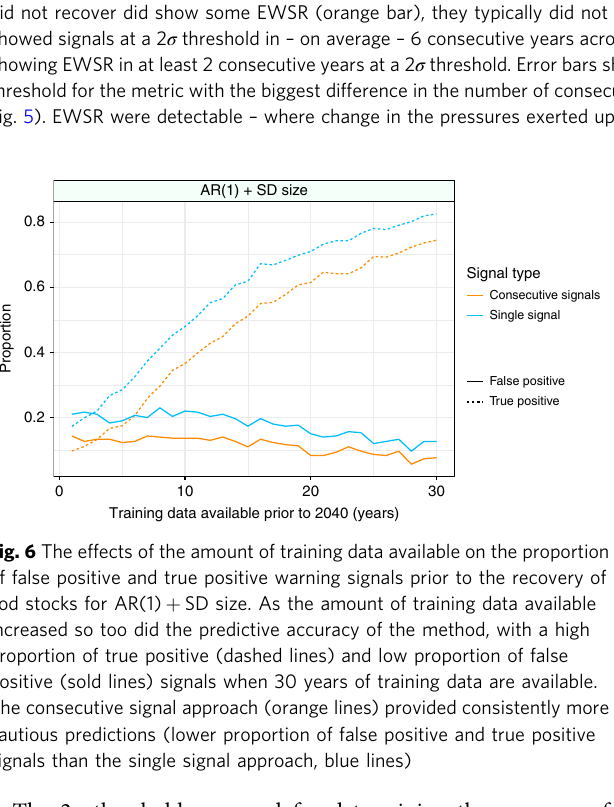
NATURE COMMUNICATIONS| (2019) 10:1681